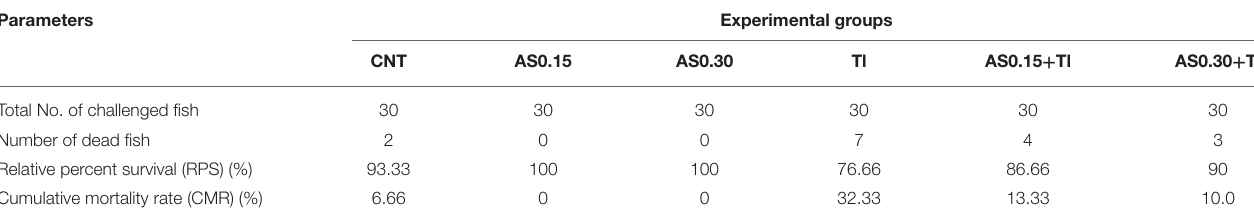
TABLE 4 | Effect of dietary supplementation with Astragalus membranaceus polysaccharides (AS) levels (0.15 and 0.30%) and/or exposure to thallium (Tl) toxicity (1/10th LC50; 41.9 µ g/l) for 8 weeks on the disease resistance of Nile tilapia challenged with Aeromonas hydrophila . Parameters Experimental